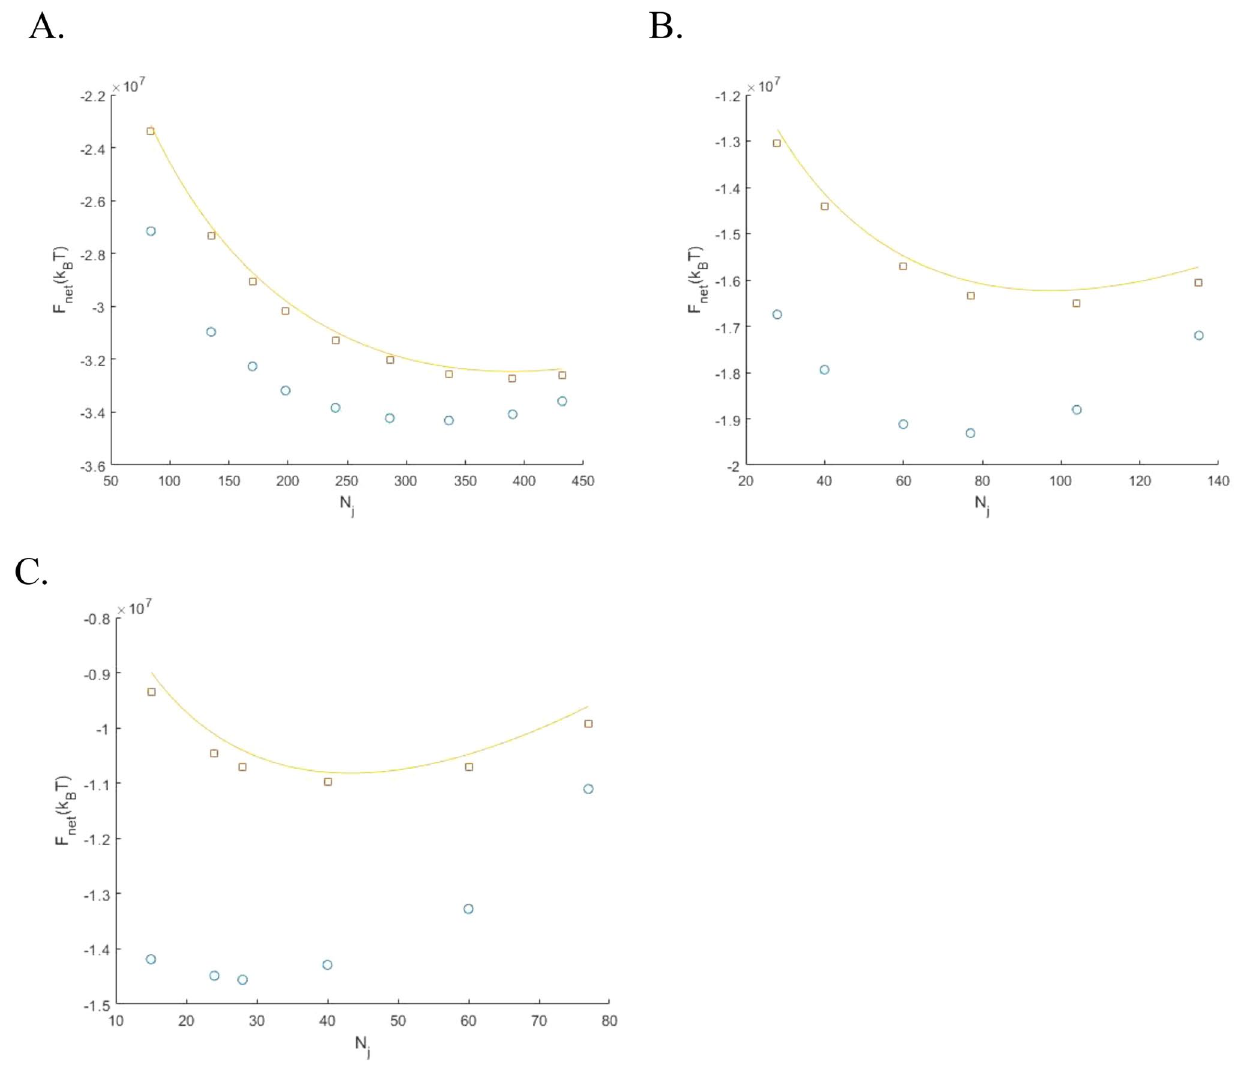
Figure 6. The total energy of the optimal irregular configuration (blue circles) and of the hexagonal configuration with symmetric junctions (red squares) as functions of the number of junctions. The number of sources, N M , are equal for the hexagonal and irregular networks. The solid line shows the results of calculations according to the approximate analytical equation (Eq. 13) which neglects the contributions of the network edges connected to the boundary. The parameter values used are: γ 2 µm ( C µm ( B ) and, l c =